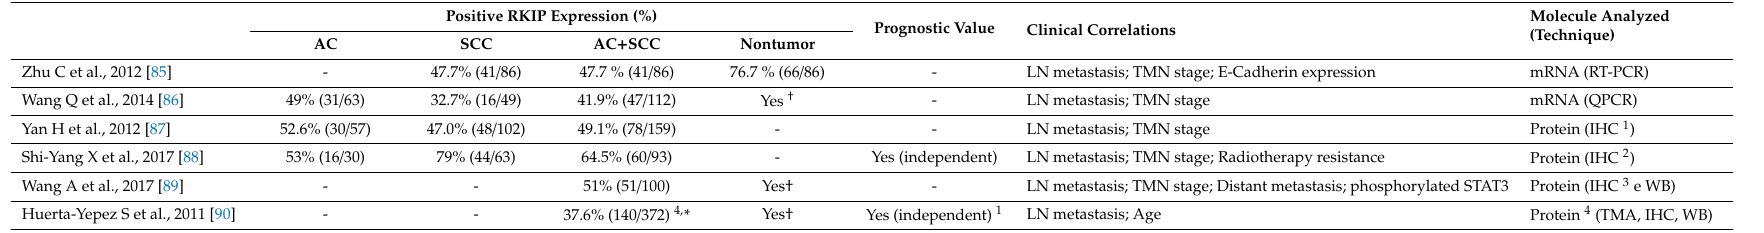
Table 2. Raf kinase inhibitory protein (RKIP) expression and its clinical impact in lung cancer